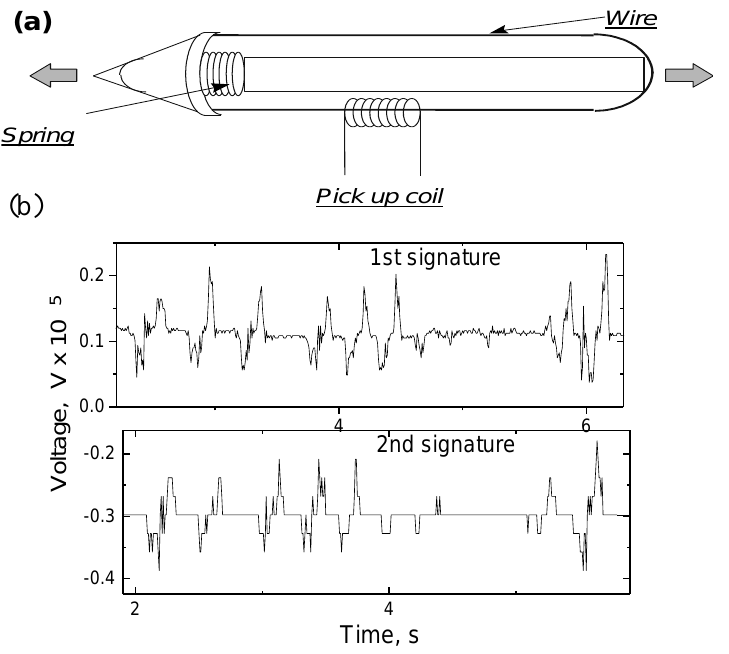
Figure 15. Schematic representation of the magnetoelastic pen (a) and two magnetoelastic signatures (b)